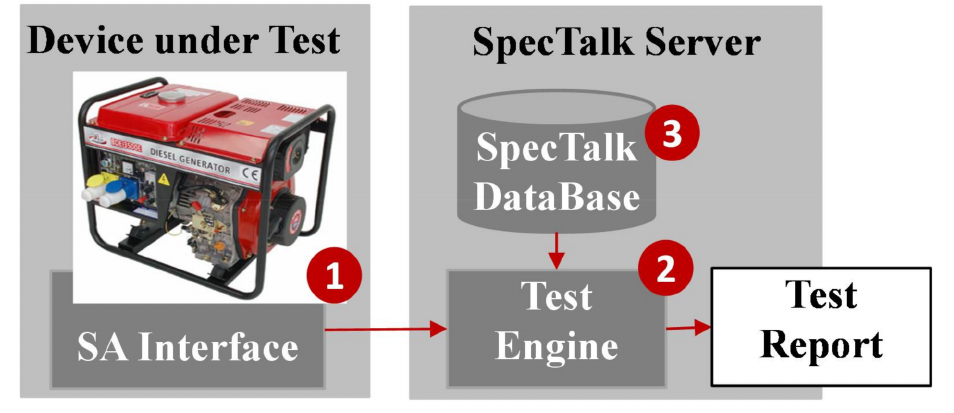
Figure 9. The SpecTalk test process.